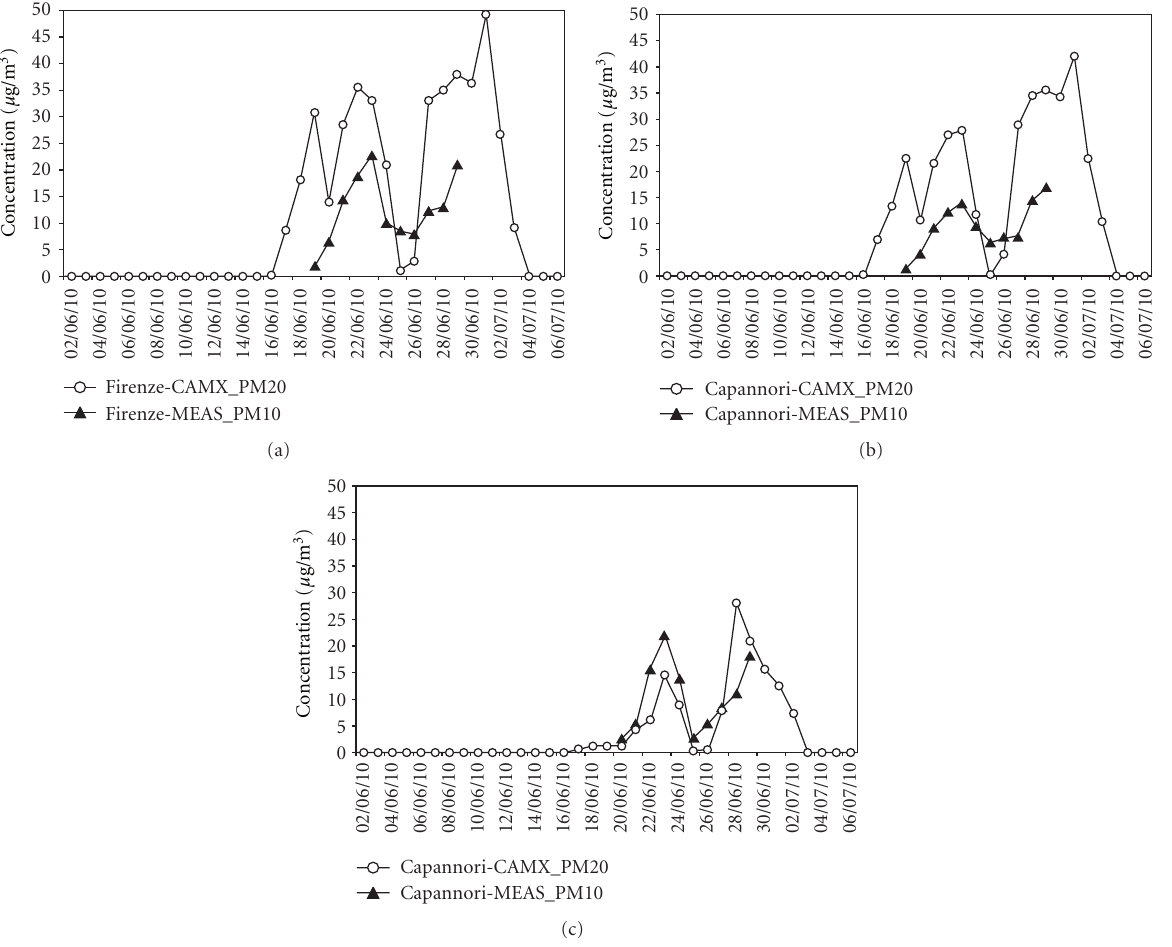
Figure 9: Comparison between mean daily modeled dust concentrations (CAMX PM20) and Saharan dust contribution to PM 10 obtained by ground measurements (MEAS PM10), in Florence, Capannori-Lucca, and Grosseto (Tuscany, Italy). obstructing the dust intrusions from higher to lower